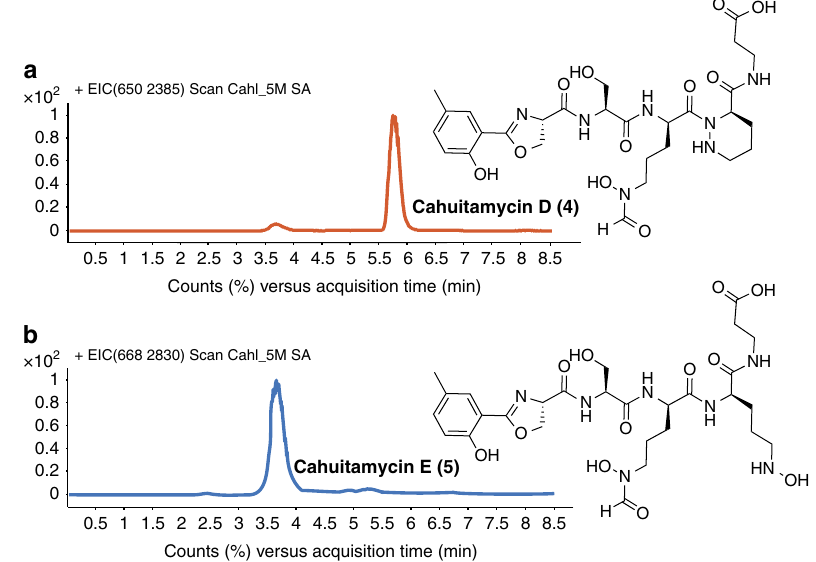
Figure 4 | Mutasynthetic generation of cahuitamycins D and E (4 and 5) and their complete structures. LC-ESI-MS chromatograms of 4 ( a ) and 5 ( b ) obtained from a culture of the cahI deletion mutant DHS334 supplemented with 100 m M of 5-methylsalicylic